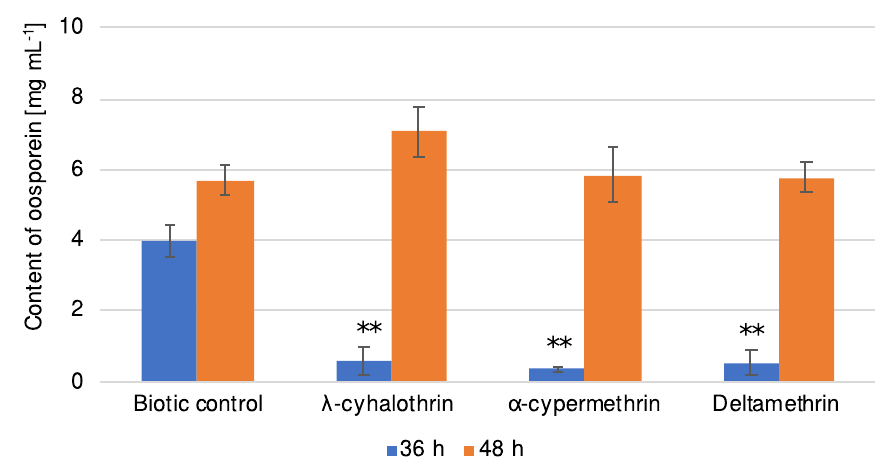
Figure 3. Content of oosporein [mg mL −1 ] in B. bassiana after 36 and 48 h of cultivation with λ-cyhalothrin, α-cypermethrin, and deltamethrin at a concentration of 100 mg L −1 . All samples were prepared in triplicate,